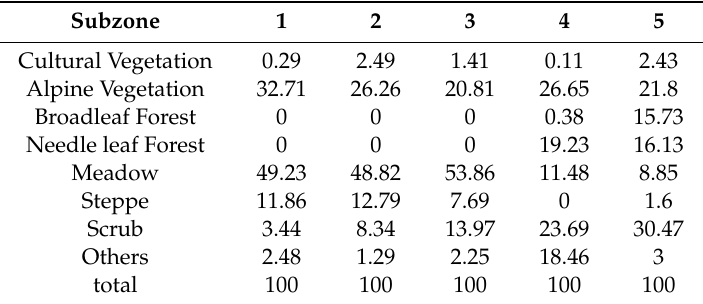
Table 2. Proportion of di ff erent vegetation types in each